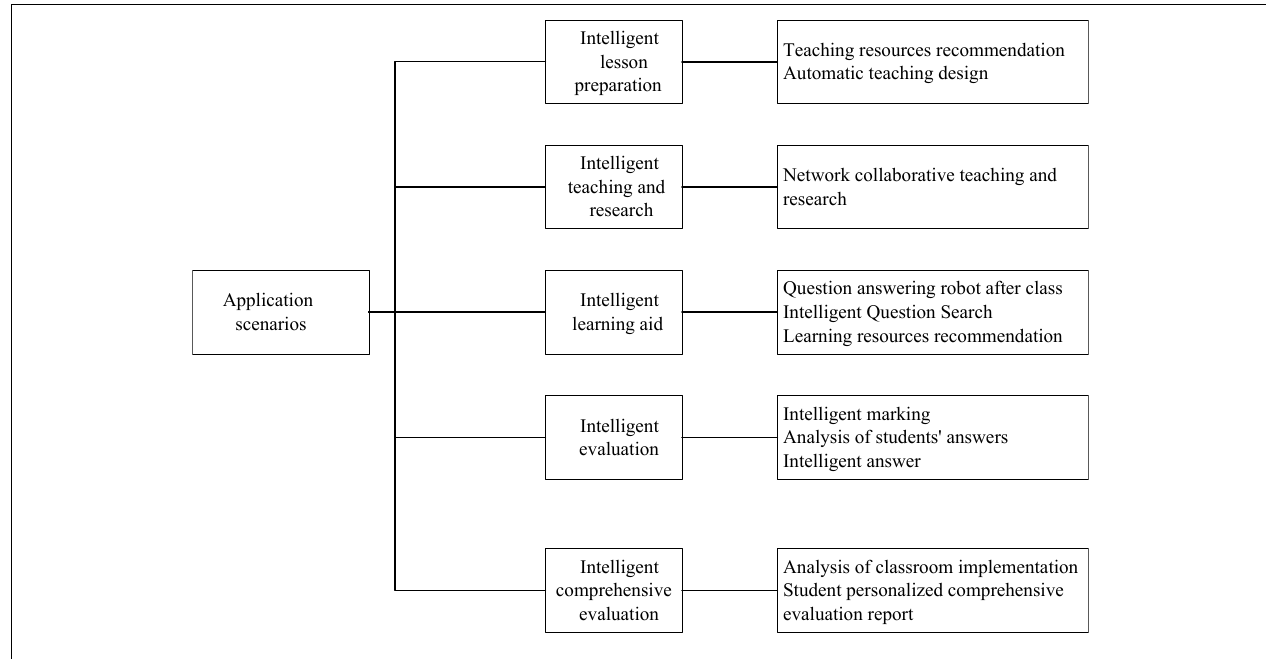
FIGURE 4 | The application of DL in